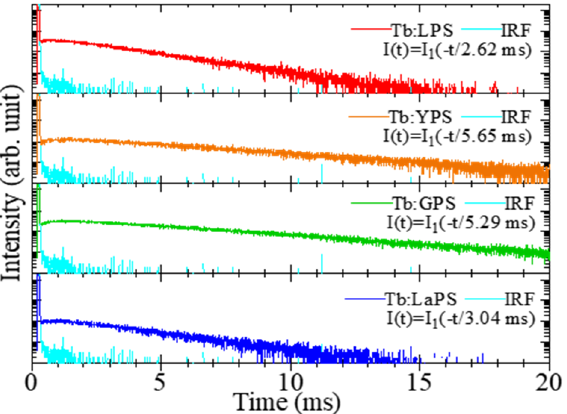
Figure 5. PL decay time profiles of Tb-doped LPS, YPS, GPS, and LaPS samples. Observation and excitation wavelength are 550 and 340–390 nm, respectively.